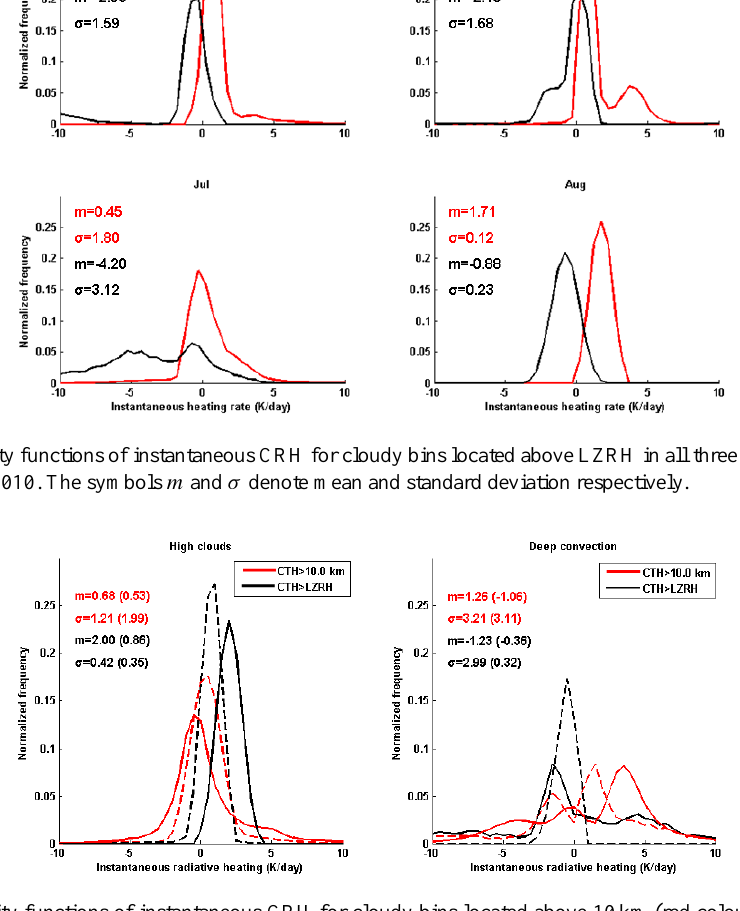
Figure 12. Probability density functions of instantaneous CRH for cloudy bins located above 10km (red colour) and LZRH (black colour) during active and break periods of the monsoon. The solid lines show PDFs for active periods and dashed lines for break periods of the monsoon. The symbols m and σ denote mean and standard deviation respectively. The values in brackets are for the break periods of